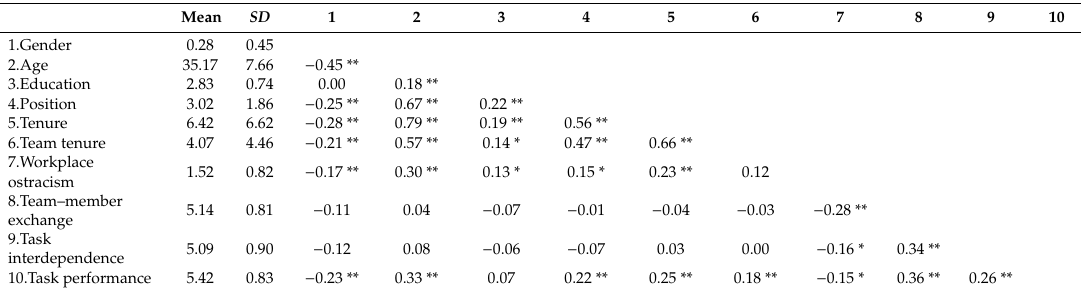
Table 1. Means, standard deviations, and zero-order correlations.